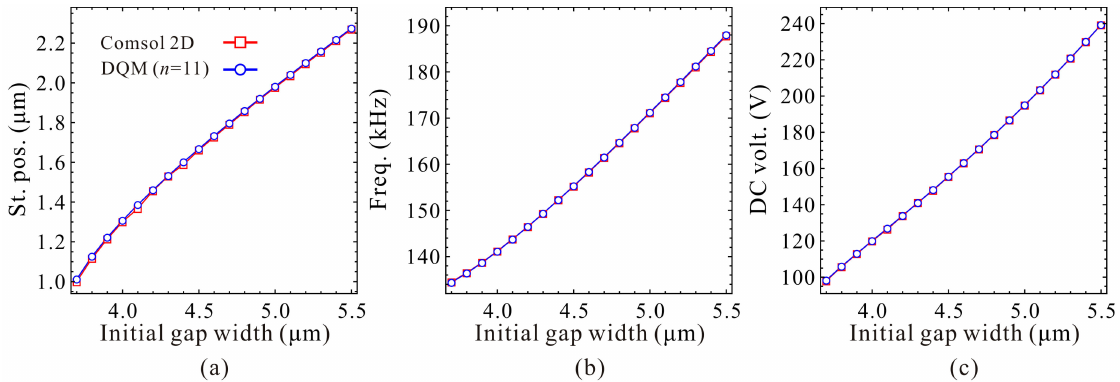
Figure 18. Quantitative property of the static position (St. pos.) ( a ), fundamental frequency (Freq.) ( b ) and DC voltage (DC volt.) ( c ) corresponding to point C 2 on frequency curve versus initial gap